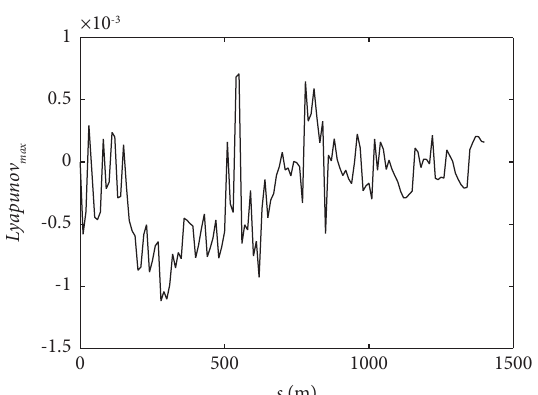
Figure 15: Maximum Lyapunov exponents of normal displace- ment with cable coordinates.